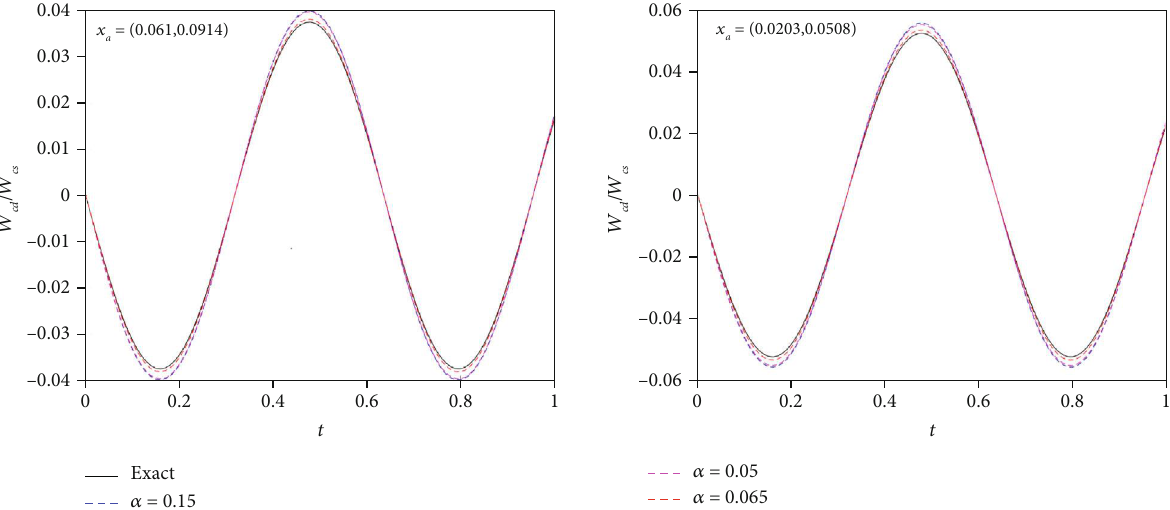
Figure 6: Convergence and accuracy of the numerical results for di ff erent values of α for the case where the dimensional di ff erential equation of motion of the beam is discretized using the DQM ( n = 31